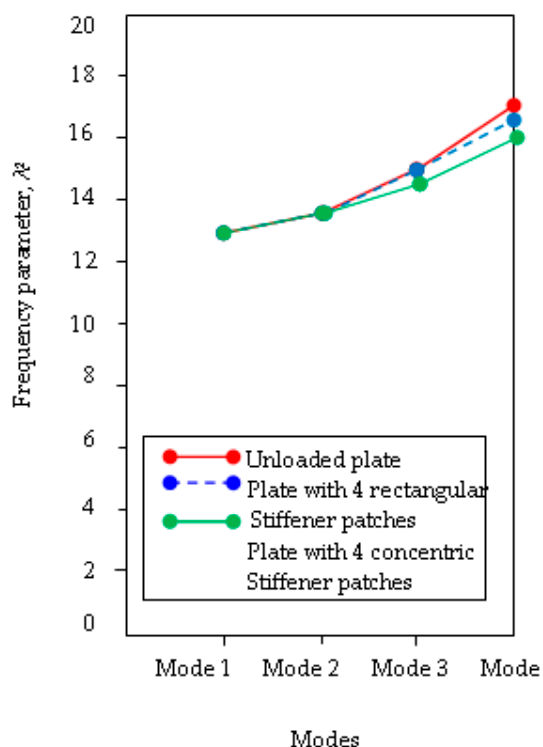
Figure 6. Comparison of % variation of natural frequency parameter with different modes for a uniform plate with taper ratio, T x = 0.00 and with different attachment of concentric stiffener patches.